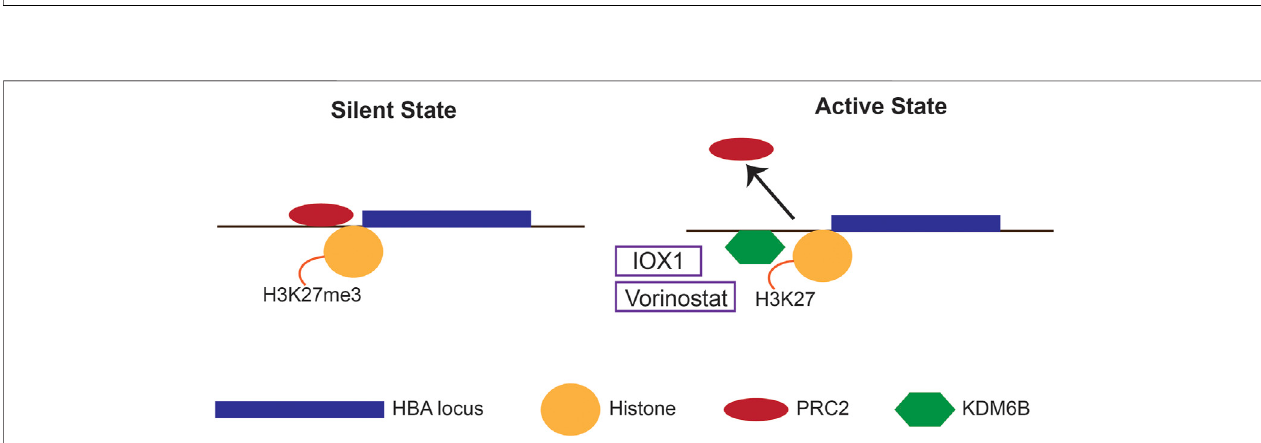
FIGURE 3 | Epigenetic mechanisms regulating α -globin expression. In the silent state, the human α -globin locus is silenced through binding of the Polycomb repressive complex 2 (PRC2) and its associated repressive chromatin signature H3K27me3. In the active state, the PRC2 is detached, and histone lysine demethylase 6B (KDM6B) is recruited to facilitate the removal of the H3K27me3. Epigenetic drugs that down-regulate α -globin expression (IOX1 and vorinostat) inhibits